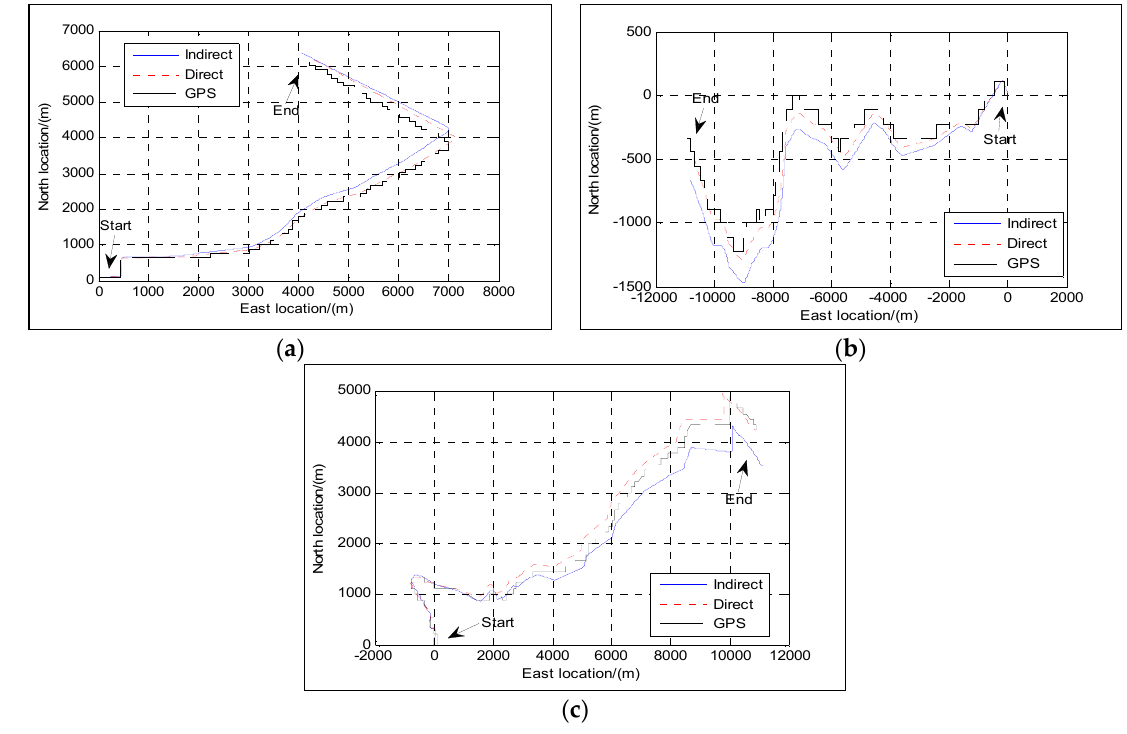
Figure 9. Position: ( a ) Trajectory 1; ( b ) Trajectory 2; ( c ) Trajectory 3.